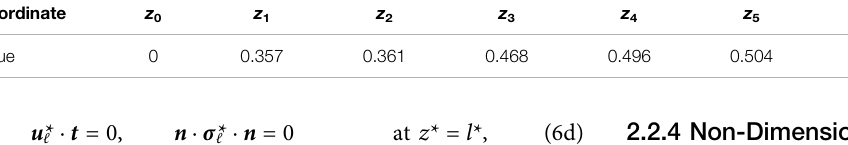
TABLE 3 | Dimensionless coordinates, separating valve tubing, valve, resistor tubing, channel, and scaffold regions, computed from dimensional values are ( z 0 * , ... , z 9 * ) (cid:2) ( 0 , 0 . 5 , 0 . 505 , 0 . 655 , 0 . 695 , 0 . 705 , 0 . 745 , 0 . 895 , 0 . 9 , 1 . 4 ) .